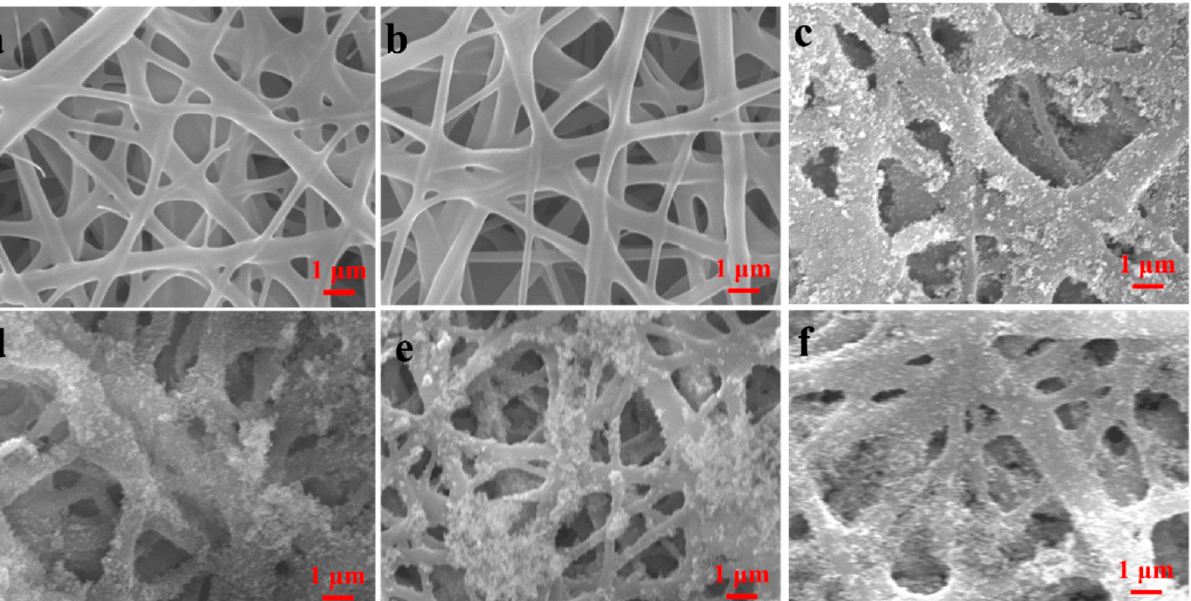
Figure 3. Pore size distribution of the SBS/PDA/SiO 2 fibrous membranes with different SiO 2 NPs concentrations. Table 1. Pore sizes of the fibrous membrane. Sample